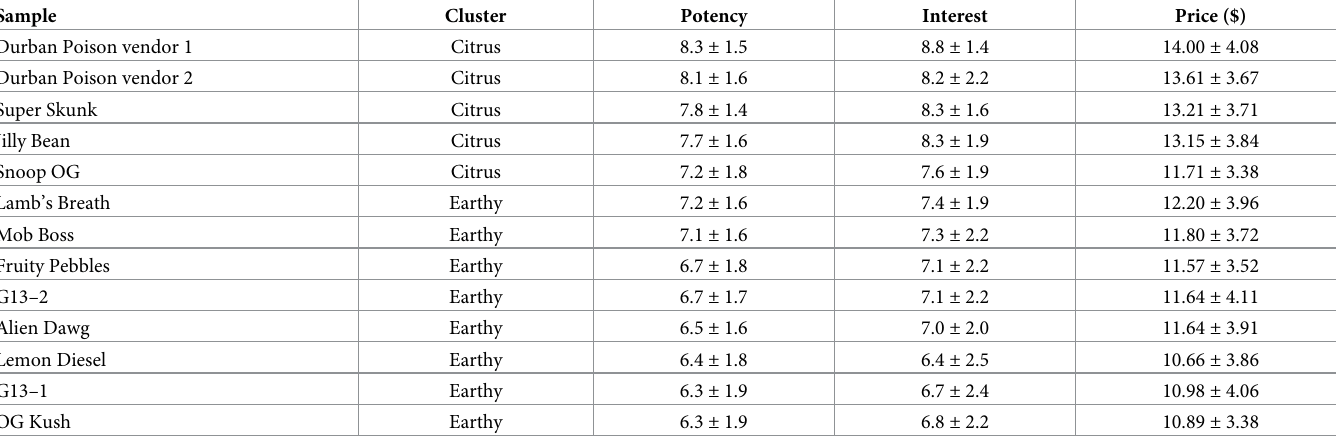
Table 2. Cluster membership and smell-based product evaluation ratings for each sample.